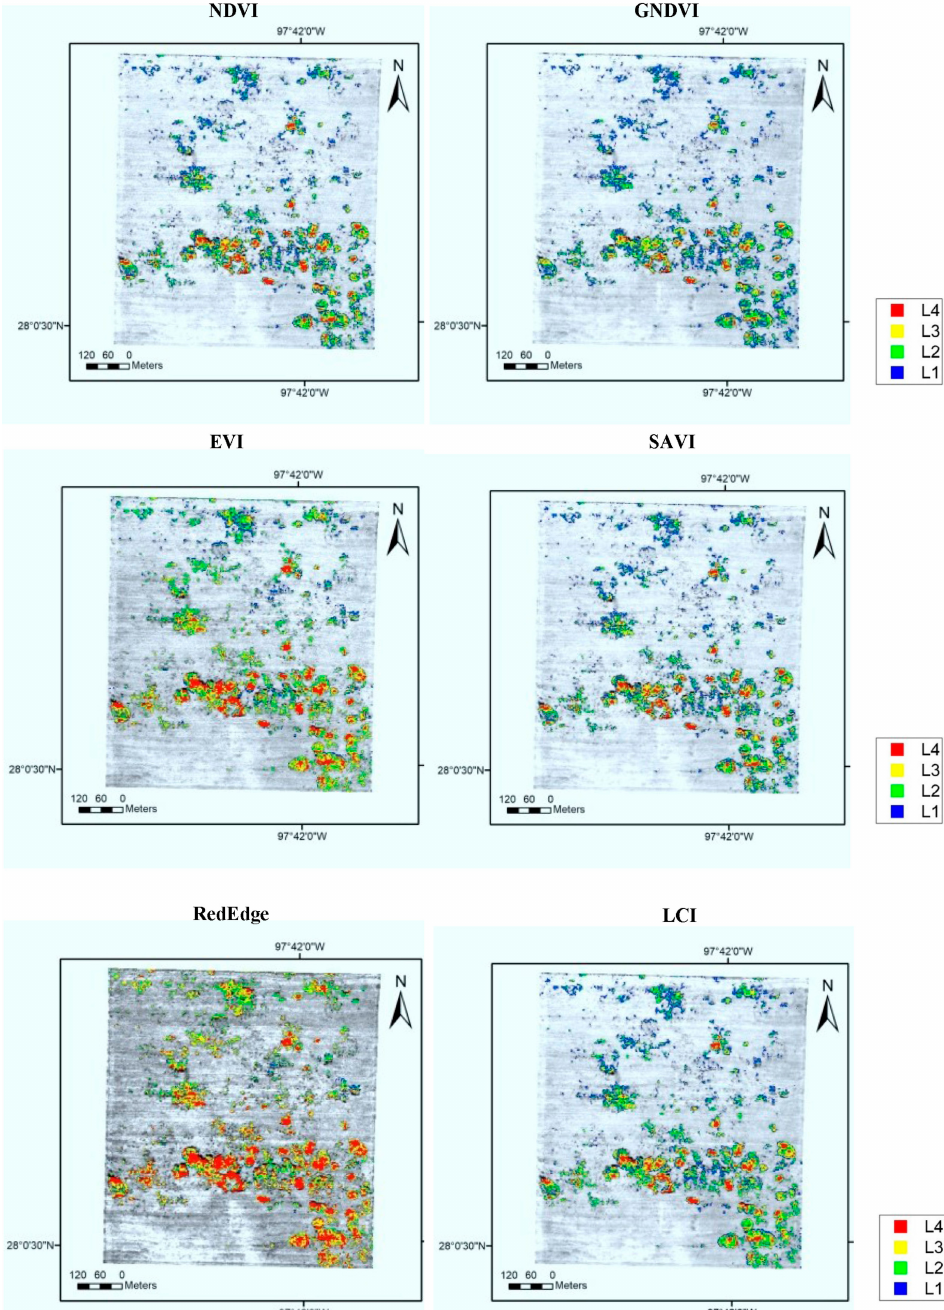
Figure 7. Distribution maps of the severity levels of cotton root rot in Field